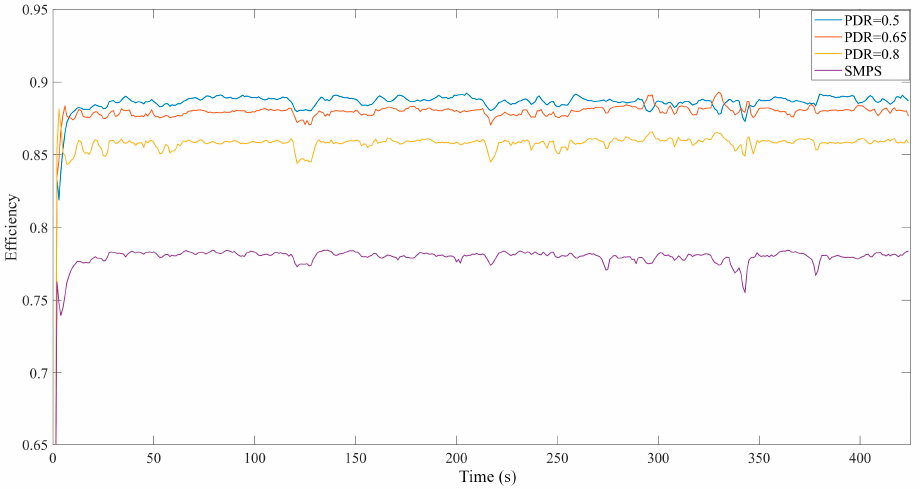
Figure 14. Overall efficiency comparison under plowing cycle.